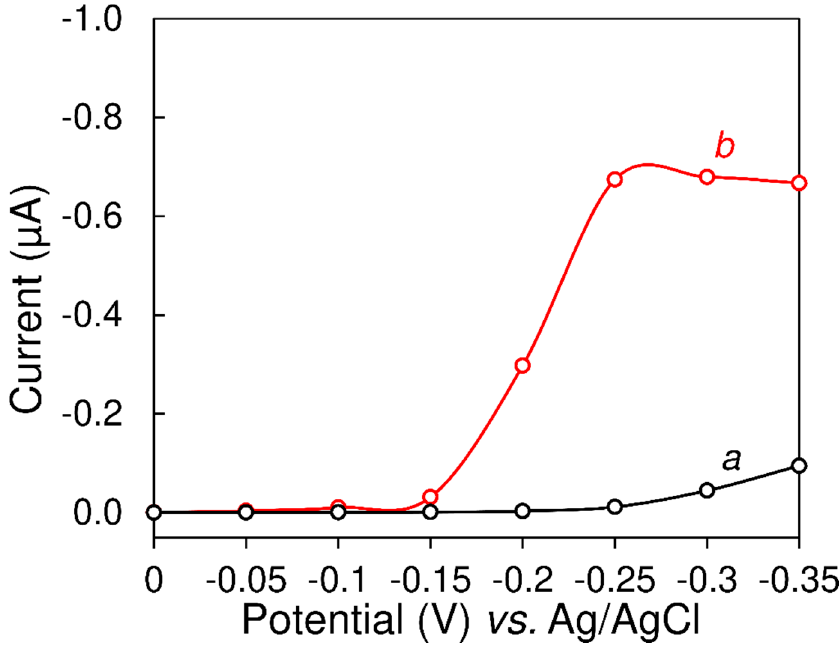
Figure 4. The dependency of the amperometric response on the magnitude of the working potential applied at the CPE/MWCNTs (curve a ) compared to CPE/MWCNTs/TYR/Nafion ® (curve b ); analyte 500 µmol·L − 1 Trolox; supporting electrolyte 0.01 mol·L − 1 PB of pH 7.0; stirring speed of 400 rpm.